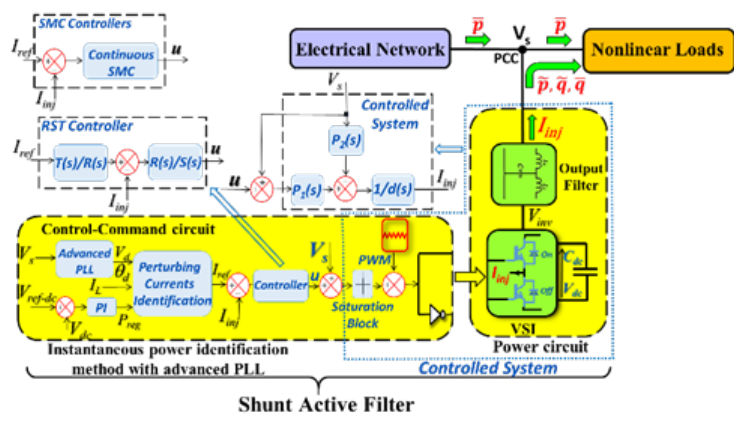
Figure 1. The shunt active filter environment.